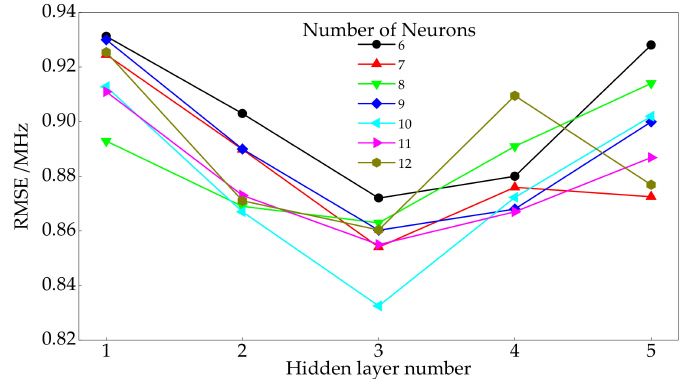
Figure 2. Root mean square error (RMSE) of Elman neural network (ENN) model under di ff erent hidden